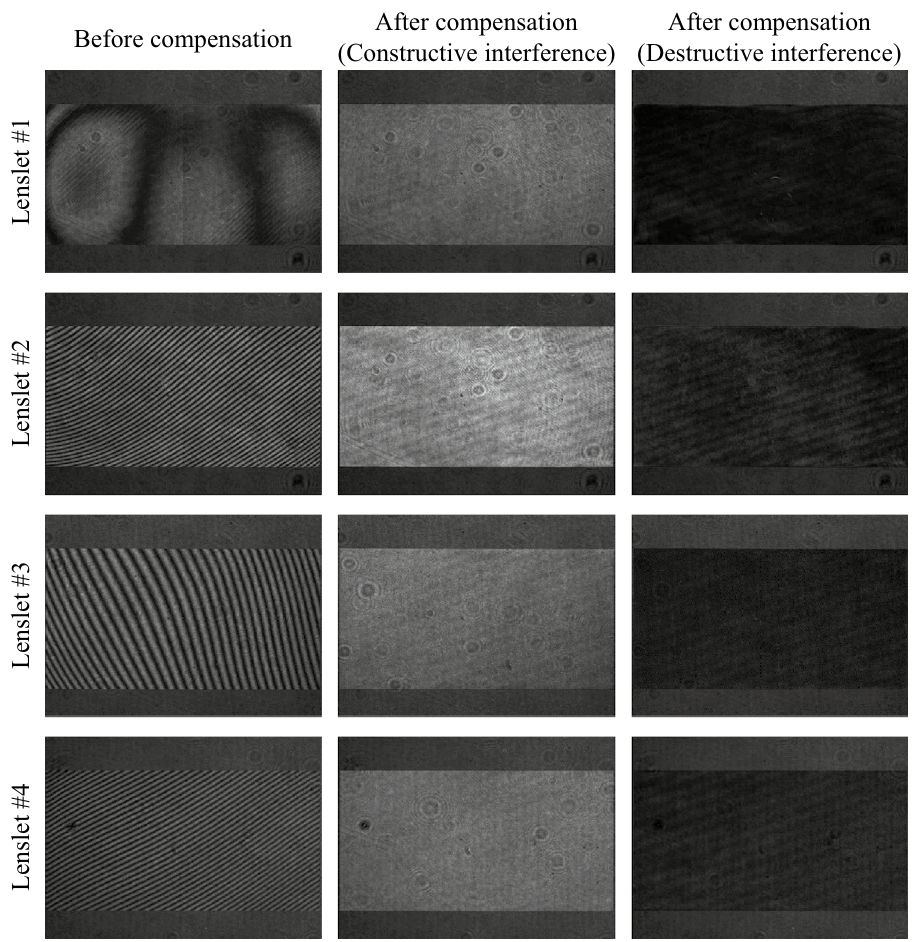
Figure 9. The interference pattern between the reference plane wave and the directional plane wave generated by lenslet #1 to lenslet #4. The aberration pattern is flattened by compensation using the measured wavefront. By changing the piston phase of the wavefront, constructive and destructive interference can be